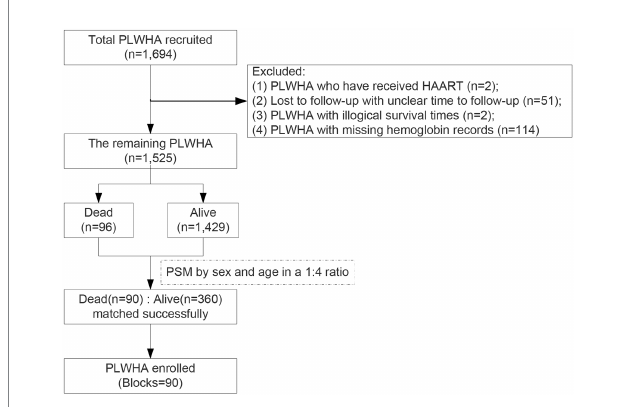
FIGURE 1 A flowchart of participants’ enrollment. PLWHA, people living with HIV/